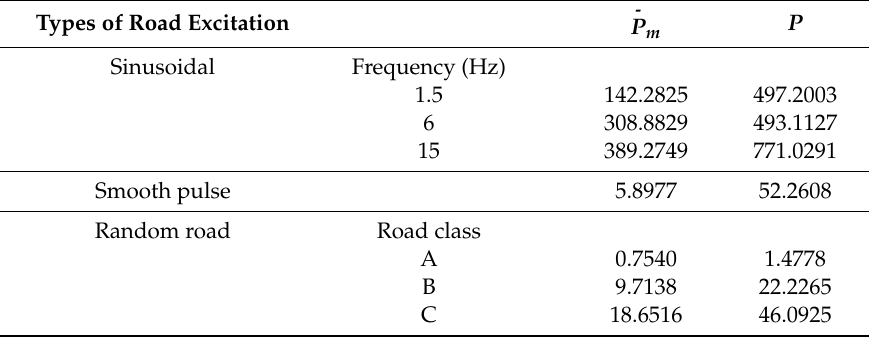
Table 2. The average and e ff ective output power of the regenerative